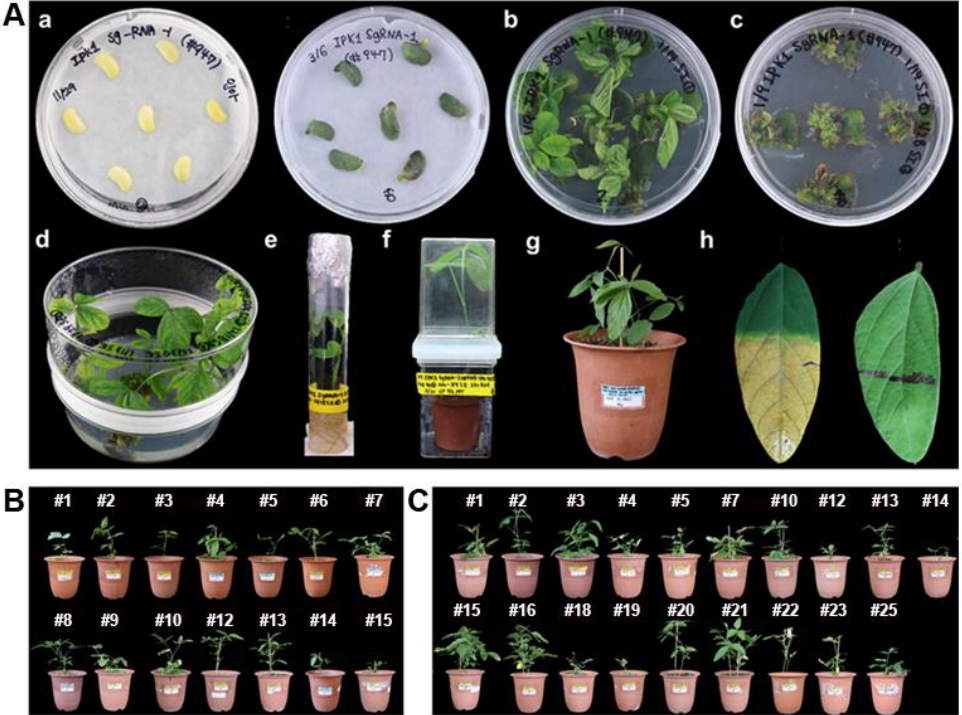
Figure 3. Production of Gmipk1 gene-edited soybean transgenic plants via Agrobacterium -mediated transformation. ( A ) Generation of CRISPR/Cas9-mediated Gmipk1 gene-edited transgenic soybean plants. (a) Cocultivation of half-seeds after inoculation stage (left) and at 5 days after inoculation (right). (b) Shoot induction on shoot induction medium (SIM) without PPT selection for 14 days. (c) Shoot induction on SIM with 10 mg L − 1 PPT for another 14 days. (d) Shoot elongation on shoot elongation medium (SEM) with 5 mg L − 1 PPT selection. (e) Root formation on rooting medium (RM). (f) Acclimation of a putative transgenic plant in a small pot. (g) Transgenic plant (T 0 ) grown in a greenhouse. (h) Leaf coating with 100 mg L −1 PPT showing sensitivity in the leaf of the NT plant (left) and resistance in the leaf of the transgenic plant (right). ( B ) GmIPK1 sgRNA-1 transgenic soybean plants (T 0 ) grown in the greenhouse. ( C ) GmIPK1 sgRNA-4 transgenic soybean plants (T 0 ) grown in the greenhouse.